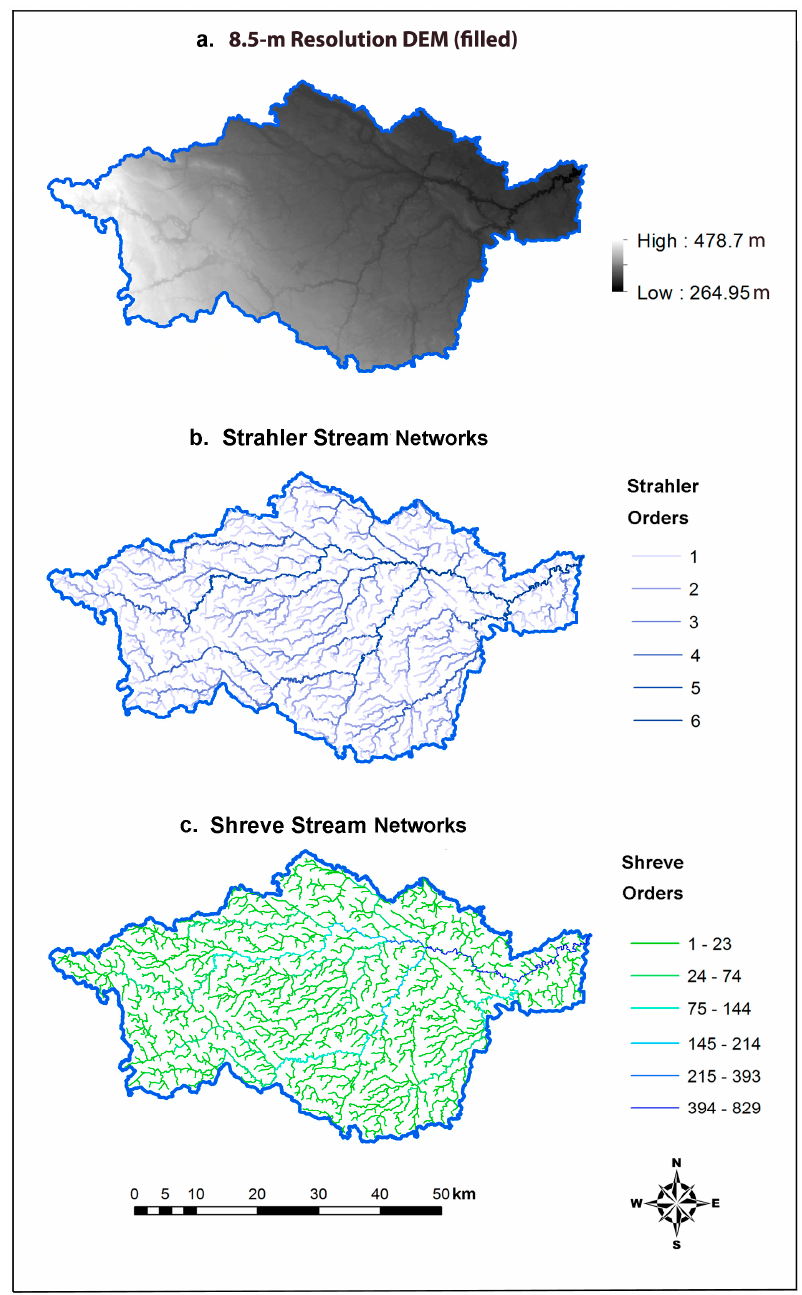
Figure 4. United States Geological Survey (USGS) 8.5 DEM and extracted stream networks in Strahler and Shreve orders.